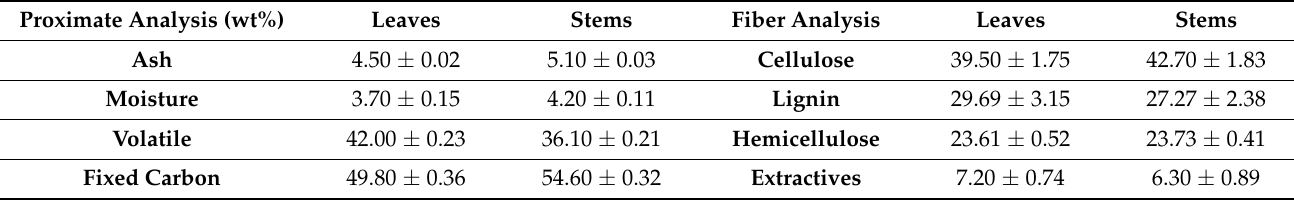
Table 2. Constitutional characteristics of Phragmites australis (% w/w ) a (source from El Shahawy and Heikal, 2018a [9]). Proximate Analysis (wt%) Leaves Stems Fiber Analysis Leaves Stems Ash 4.50 ± 0.02 5.10 ± 0.03 Cellulose 39.50 ± 1.75 Moisture 3.70 ± 0.15 Volatile Fixed